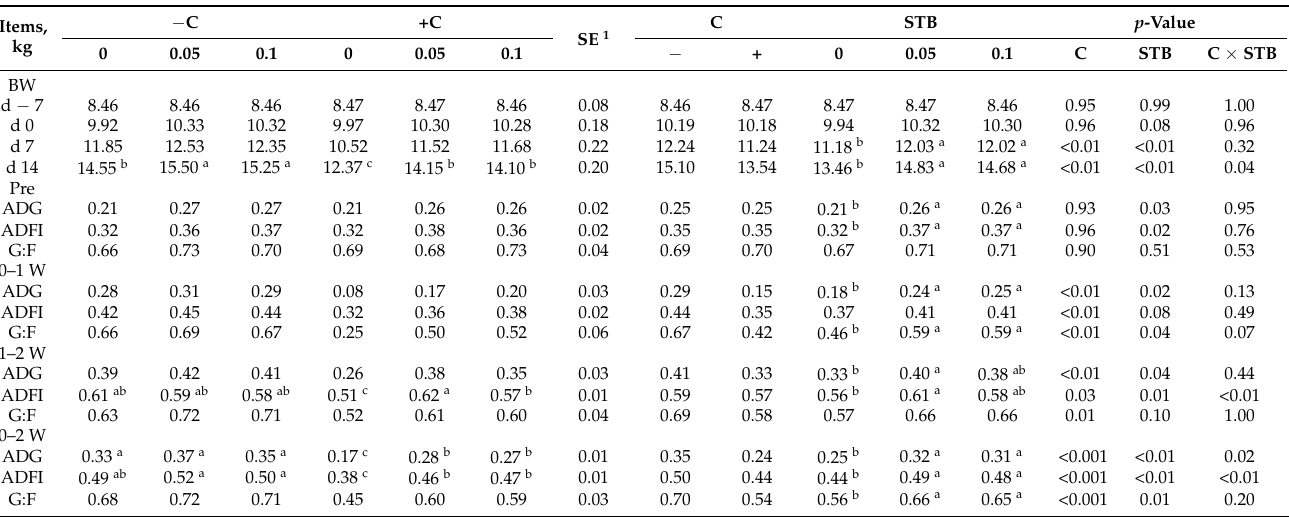
Table 2. Effects of stimbiotic supplementation on the growth performance in pigs challenged with